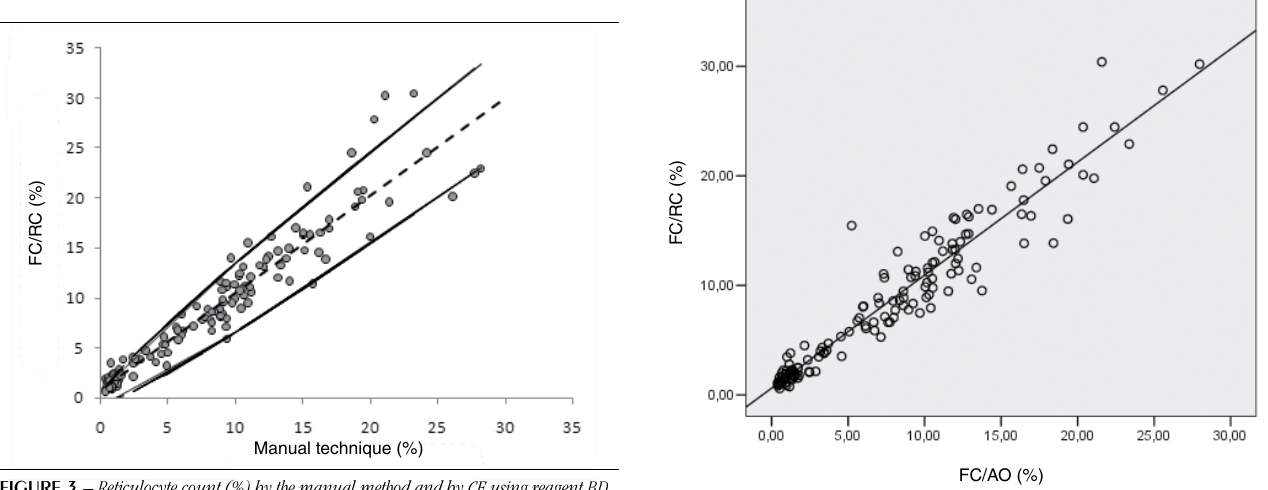
figurE 3 – Reticulocyte count (%) by the manual method and by CF using reagent BD RC ( n = 150). Continuous lines: 95% binominal confidence interval; dashed lines: linear regression between the analyzed methods; Y: 0.827 + 0.97X; r 2 : 0.92; r : 0.959 FC: flow cytometry; RC: Retic-Count TM .